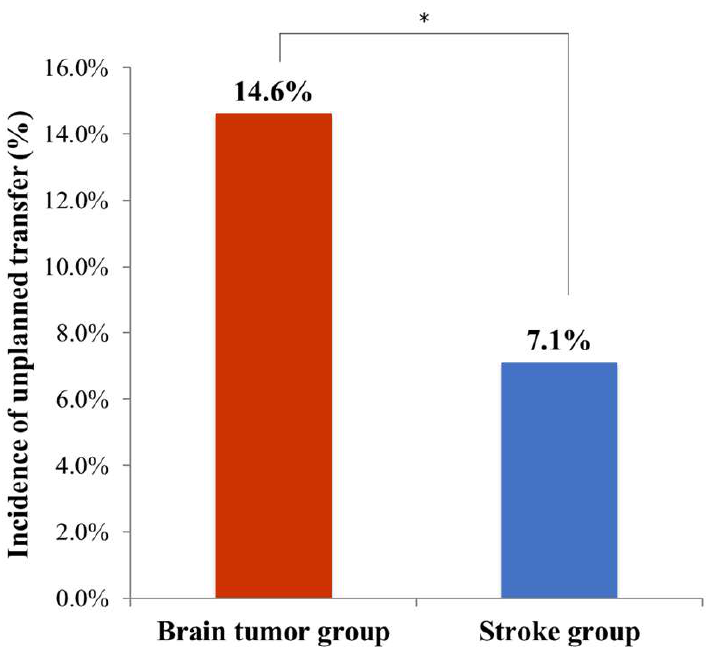
Figure 1. Incidence of unplanned transfers in each brain tumor and stroke groups. The incidence rate of unplanned transfers to acute care units was significantly higher in patients with brain tumor ( n = 20, 14.6%) than in patients with stroke ( n = 31, 7.1%) ( p < 0.05). * p < 0.05, comparison between the two groups.